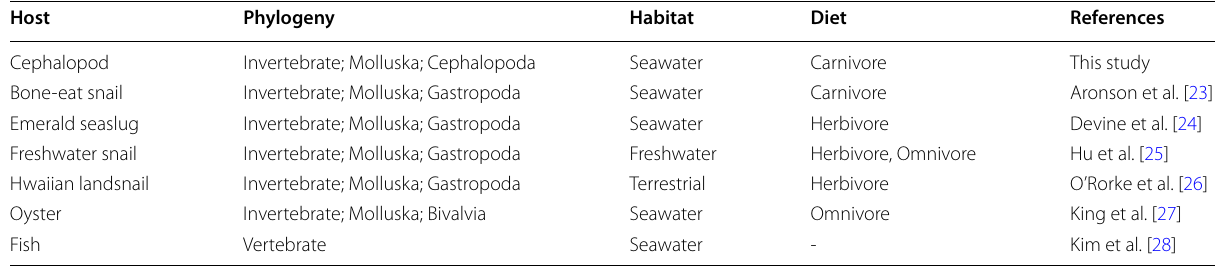
Table 1 General informations for achieved data from previous